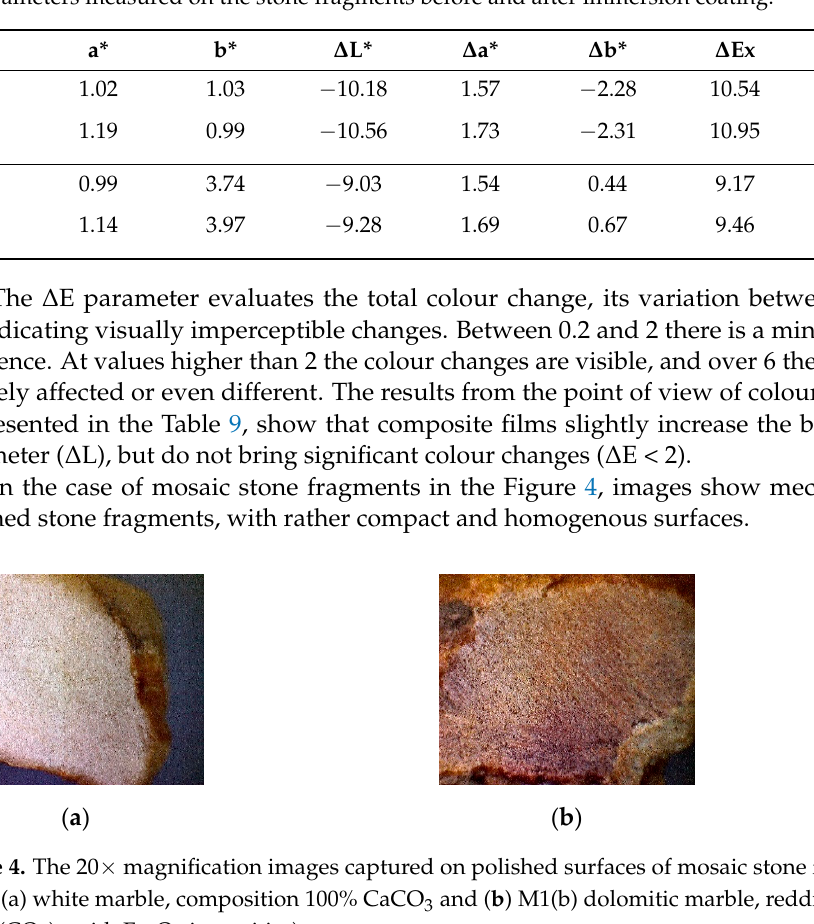
Table 8. Colorimetric parameters measured on the stone fragments before and after immersion coating.